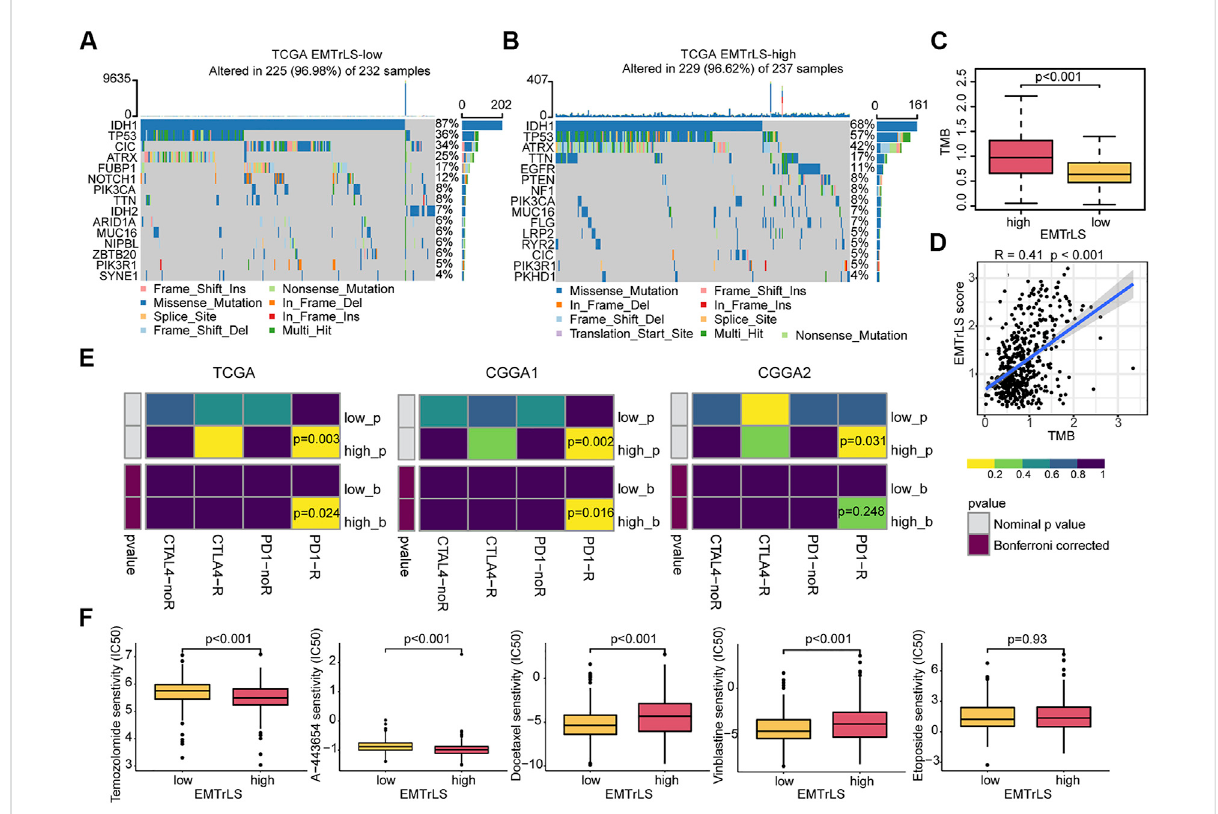
FIGURE 8 Gene mutations between (A) low and (B) high EMTrLS score samples (top 15) (C) Different EMTrLS samples have signi fi cantly different TMB (D) Correlation analysis of TMB and EMTrLS score (E) Prediction of the association of EMTrLS strati fi cation with ICB responsiveness (F) Prediction of the IC50 values for different chemotherapeutic agents in high and low EMTrLS cohorts of TCGA, including temozolomide, A-443654 (AKT inhibitor), docetaxel, etoposide, and